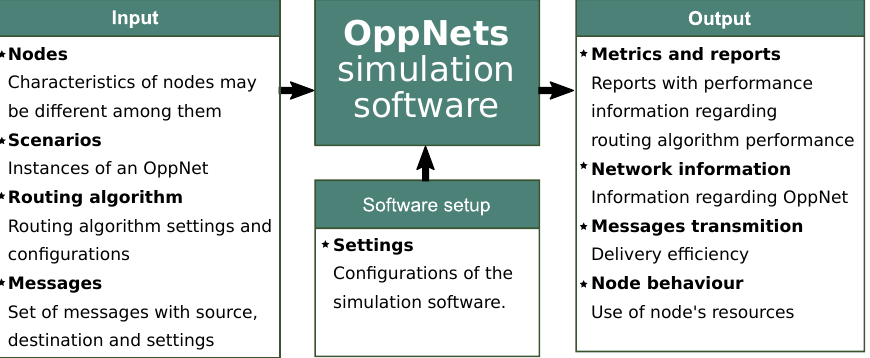
Figure 2. Scenario input, output and configuration elements that enable an OppNet